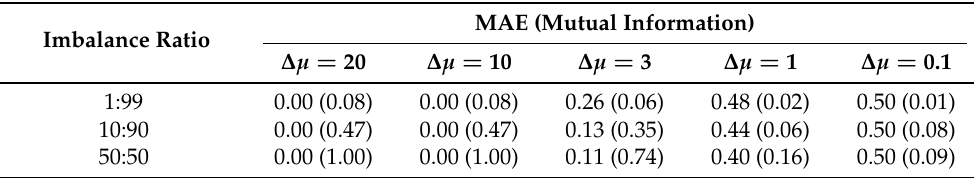
Table 1. MAE of the imbalanced binary classification problem. The imbalance ratio refers to the ratio of the number of samples in class A to the number of samples in class